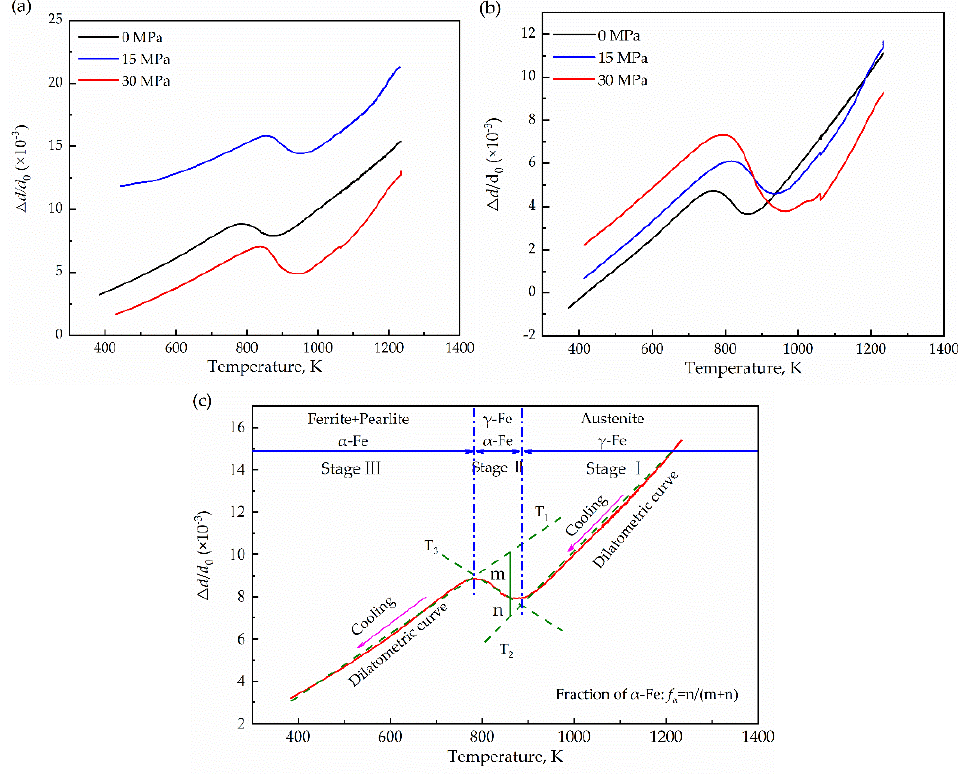
Figure 6. Dilatometric curves of specimens during cooling. ( a , b ) dilatometric curves of samples at 25 K/min, 50 K/min, respectively. ( c ) schematic diagram of the dilatometric curve, tangent- intersection method, and the level principle (0 MPa−25 K/min).